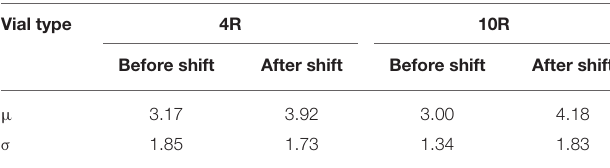
TABLE 5 | Parameters of the normal probability distribution approximating the observed numbers of thermocouple positioning errors for 4R and 10R vials. Vial